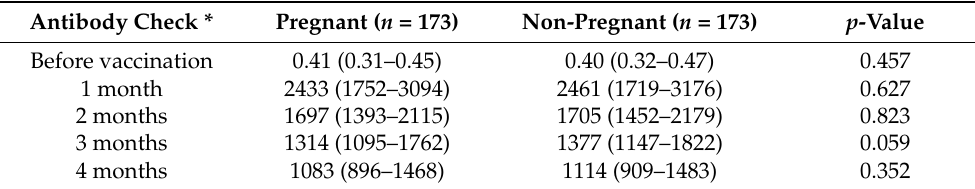
Table 4. Case-matched comparison of pregnant vs. non-pregnant patients’ spike antibodies. Patients evaluated did not have a history of SARS-CoV-2 infection.